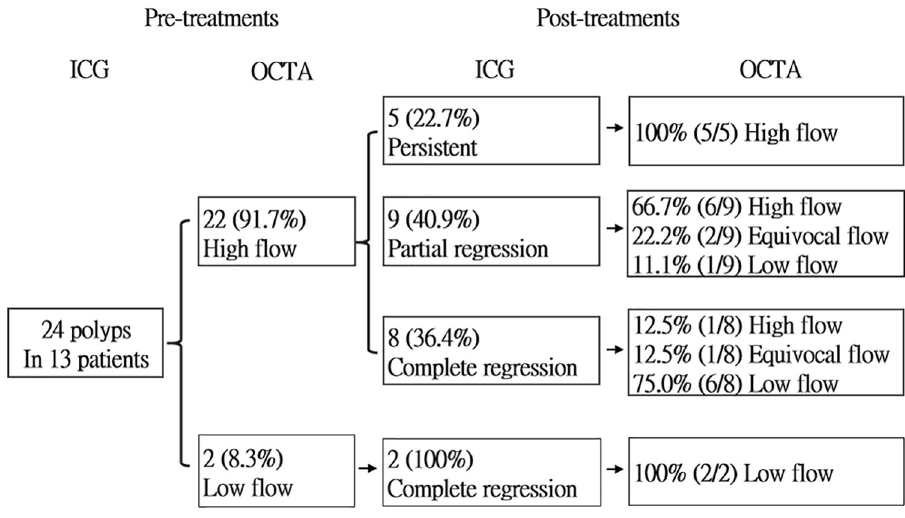
Fig 2. Outcomes of the 24 polyps detected in ICGA and flow signal changes in OCTA before and after 3 monthly loading of intra-vitreal injections of aflibercept (IVI-A).